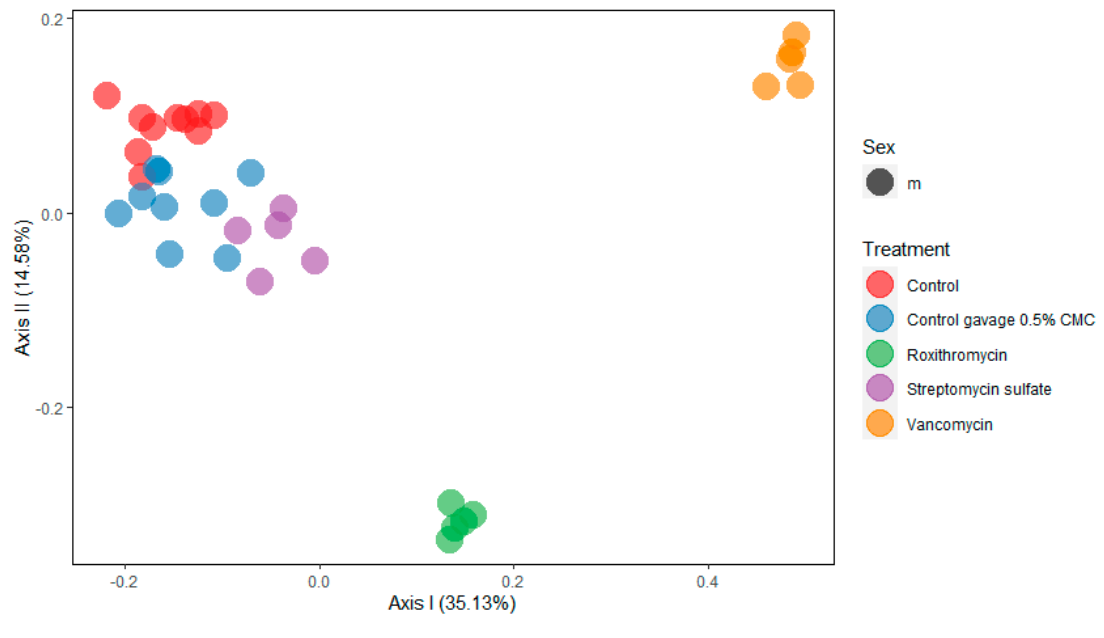
Figure 1. Principal coordinate analysis (PCoA) of the gut microbial community showing the treatment-related effect of oral administration of roxithromycin, streptomycin and vancomycin versus the feeding control and the vehicle control (0.5% carboxymethylcellulose (CMC) in drinking water).